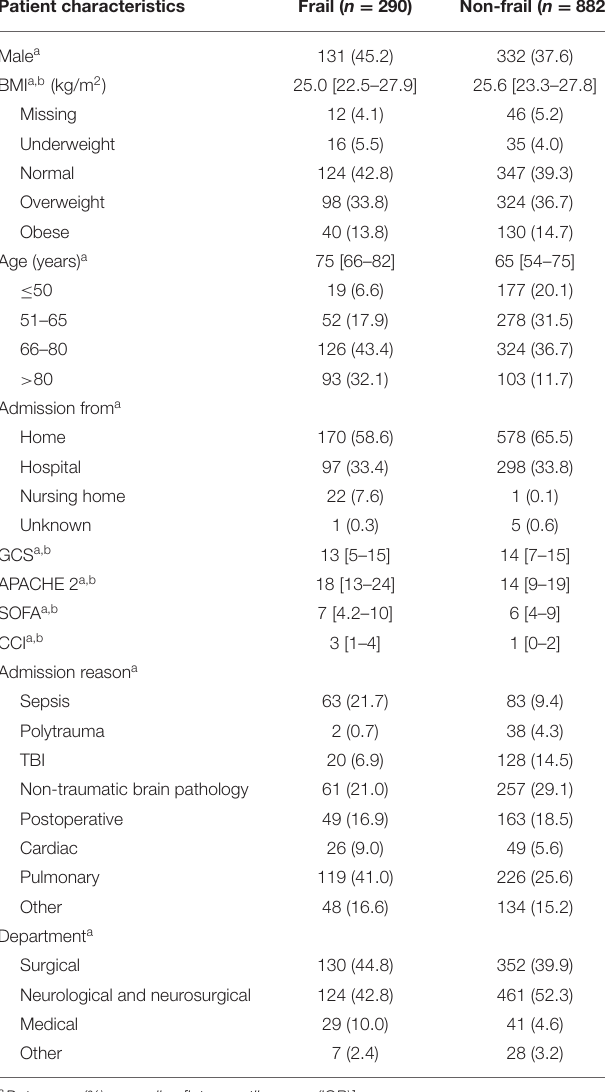
TABLE 1 | The patient characteristics of two interdisciplinary surgical intensive care units